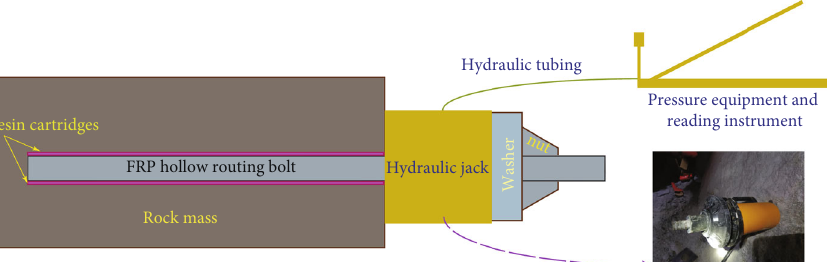
Figure 7: Installation view of the drawing equipment.